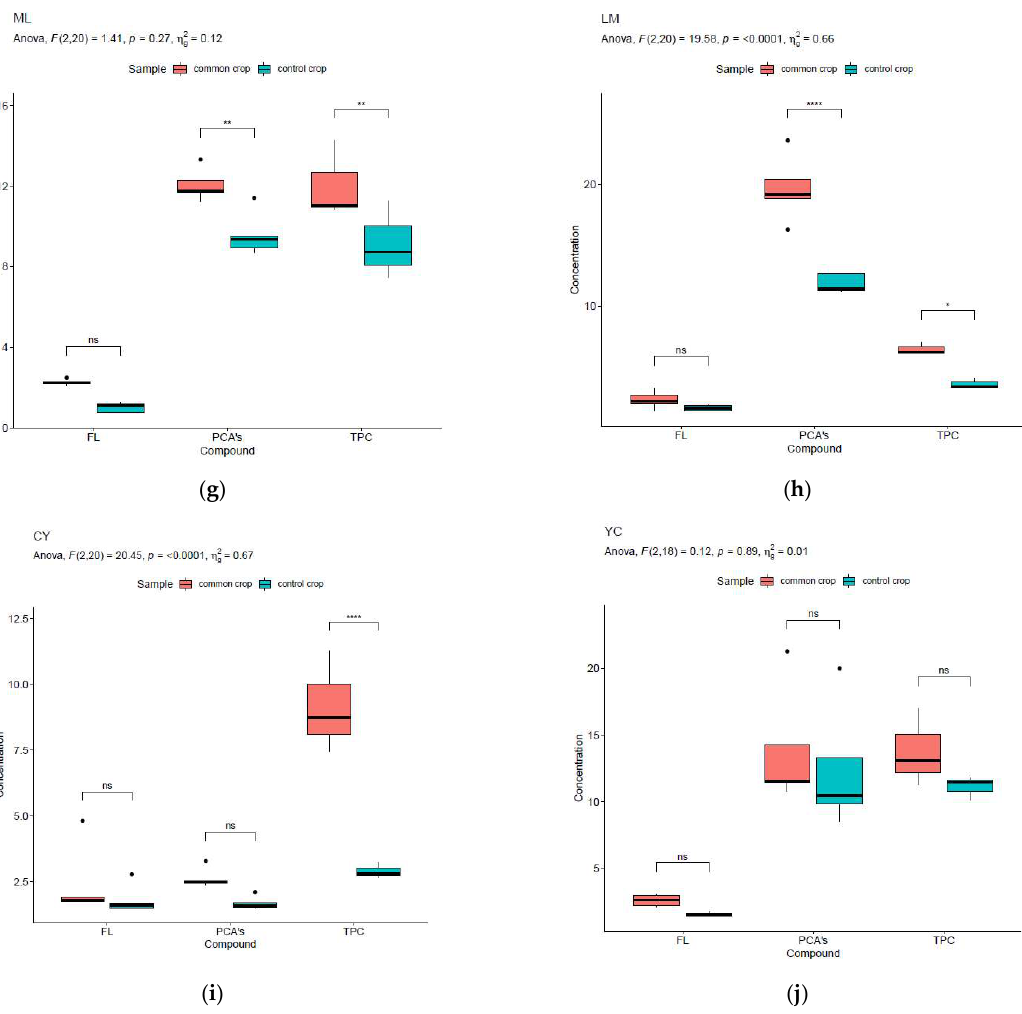
Figure 20. Statistical analysis a two-way interaction boxplot for medicinal plant. (a) A two-way interaction boxplot for TR; (b) A two-way interaction boxplot for RT; (c) A two-way interaction boxplot for SL; (d) A two-way interaction boxplot for LS; (e) A two-way interaction boxplot for MT; (f) A two-way interaction boxplot for TM; (g) A two-way interaction boxplot for ML; (h) A two-way interaction boxplot for LM; (i) A two-way interaction boxplot for CY; (j) A two-way interaction boxplot for YC.